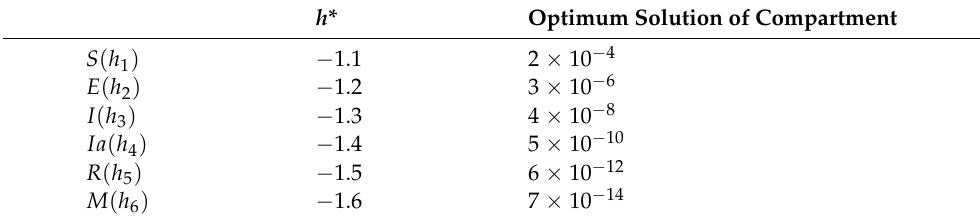
Table 3. The optimal solutions of S ( h 1 ∗ ) , E ( h 2 ∗ ) , I ( h 3 ∗ ) , I a ( h 4 ∗ ) , R ( h 5 ∗ ) , M ( h 6 ∗ ) .